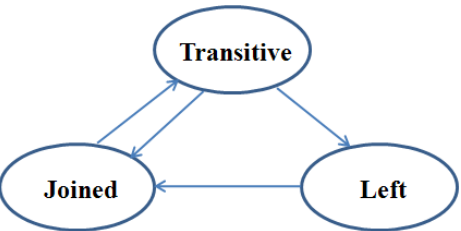
Figure 2. State transition